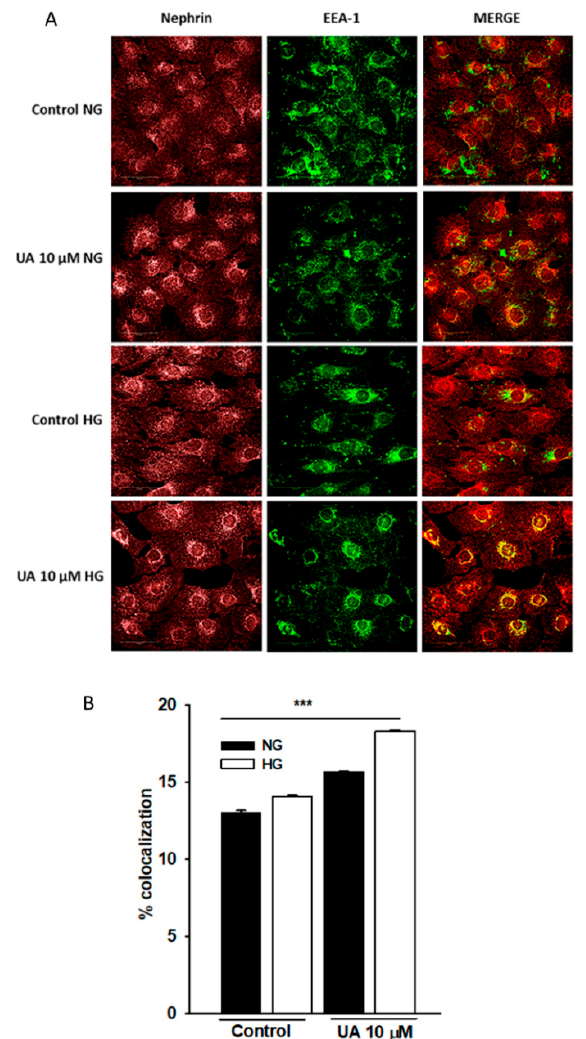
Figure 13. Upon treatment with UA, nephrin co-localization with early endosomal marker EEA1 was increased. Podocytes cultured for 7 d in normal (5.5 mM, NG) or high (25 mM, HG) glucose were incubated for 24 h with 10 µM UA. Representative confocal microscopy images of double staining against nephrin and EEA-1 ( A ). Quantification of nephrin and EEA-1 co-localization ( B ) Experiments were performed in duplicate and 500 cells were analyzed per experiment ( n = 3). ANOVA test was used to calculate p values. *** p <